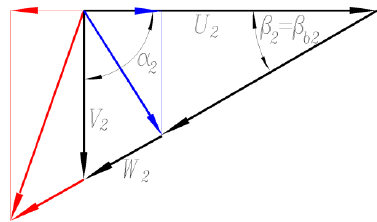
Figure 7. Definition of the runner blade port area.